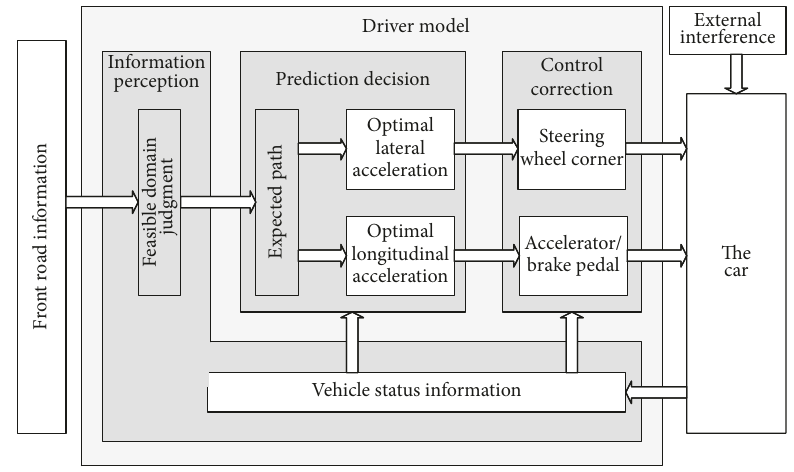
Figure 1: Basic structure of the driver